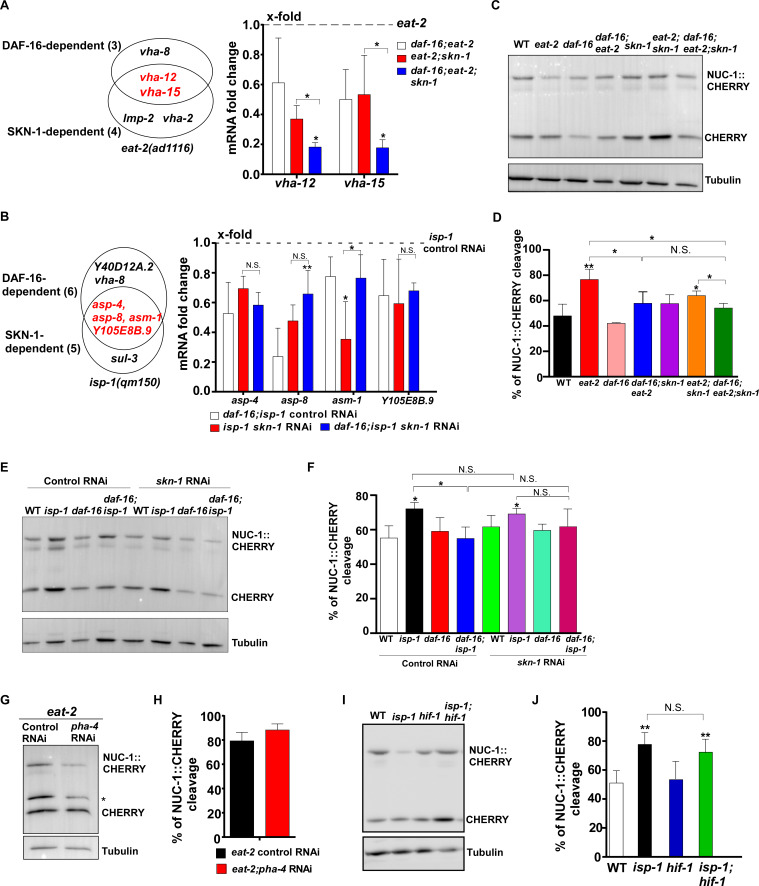
DAF-16 and SKN-1 regulate lysosomal gene expression in eat-2 and isp-1 mutants in different manners.(A, B) Left: Venn diagram showing the genes that were significantly downregulated by loss of daf-16 or skn-1 in eat-2 (A) and isp-1 (B) mutants. The genes that depend on both daf-16 and skn-1 are shown in red. Right: Expression of the DAF-16- and SKN-1-dependent lysosome genes was analyzed in the indicated double and triple mutants. The transcription level of lysosomal genes in eat-2(ad1116) (A) or isp-1(qm150) control RNAi (B) at day 1 was normalized to ‘1’ for comparison. (C–J) Western blot analysis of NUC-1::CHERRY cleavage in the indicated strains at day 1 (C, E, G, I). Quantification analyses are shown in (D, F, H, J). The asterisk in (G) indicates a non-specific band. In (A, B, D, F, H, J), three independent experiments were performed and data are shown as mean ± SD. Multiple t testing (A, B) was performed to compare datasets of eat-2;skn-1 and daf-16;eat-2;skn-1 with daf-16;eat-2 (A), or to compare datasets of isp-1 skn-1 RNAi and daf-16;isp-1 skn-1 RNAi with daf-16;isp-1 control RNAi (B). One-way ANOVA with Fisher’s LSD test (D, F, J) or paired t testing (H) was performed to compare all other datasets with wild type (D, J) or with wild type treated with control RNAi (F), or to compare eat-2;pha-4 RNAi with eat-2 control RNAi (H), or datasets that are linked by lines (A, B, D, F, J). *p<0.05; **p<0.001. All other points had p>0.05. N.S., no significance.Figure 7—figure supplement 1—source data 1.Numerical data that are represented as a bar graph in Figure 7—figure supplement 1A,B,D,F,H,J.